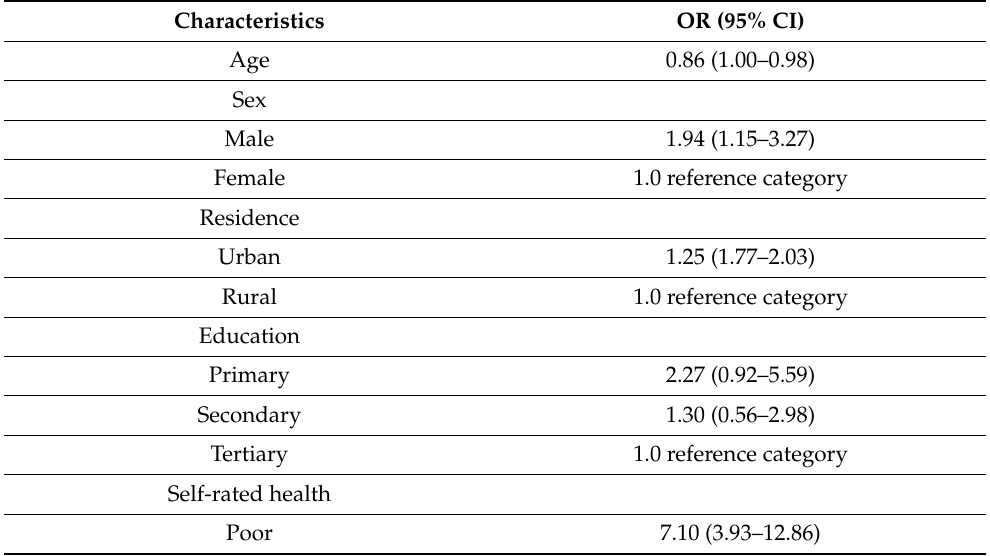
Table 2. Multivariate logistic regression analysis with a high risk of psychological distress as an outcome